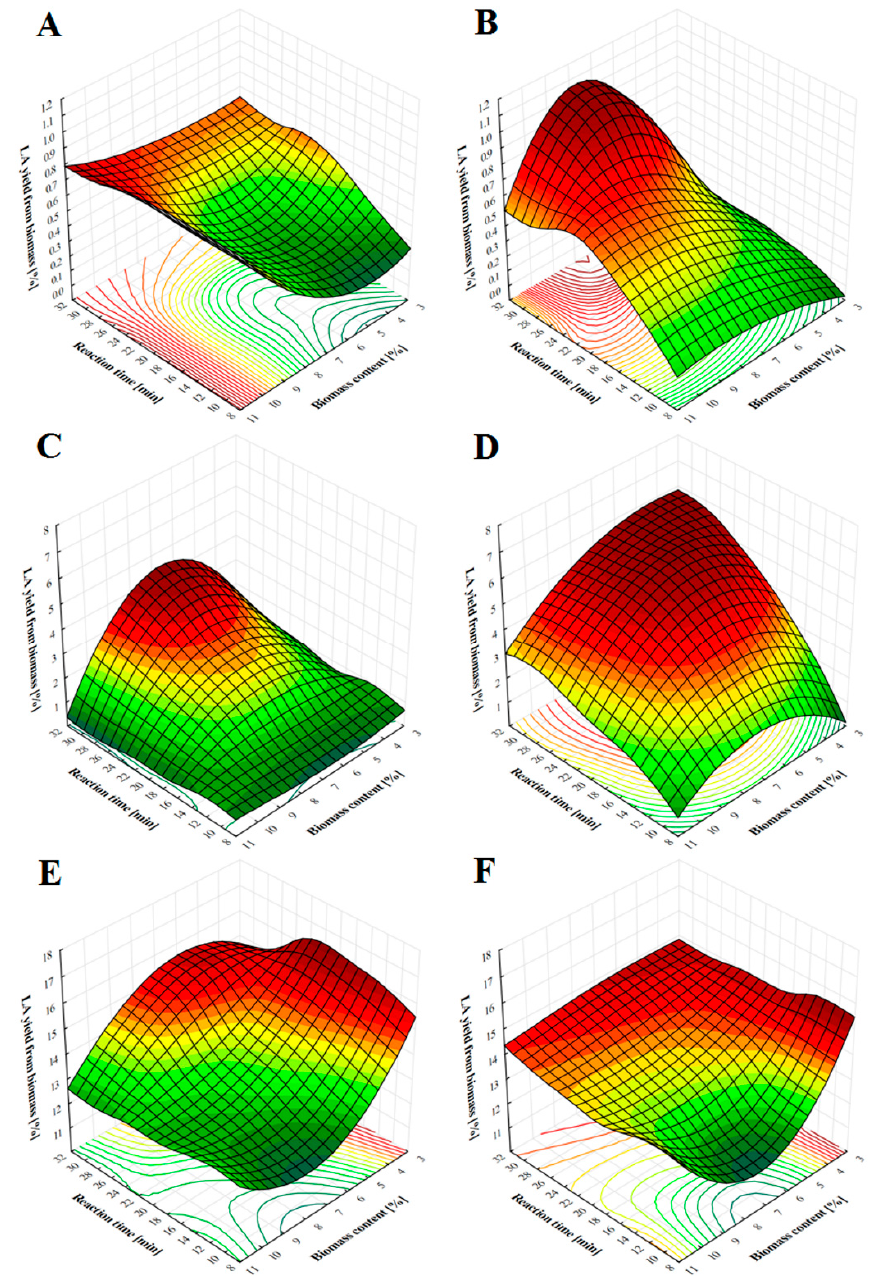
Figure 5. Response surface plot showing the effect of the interaction between biomass content of sweet cherry chips and reaction time of microwave-assisted conversion on the yield of production of levulinic acid using nitric acid at a concentration of 1% ( A ) and 2% ( B ), phosphoric acid at a concentration of 1% ( C ) and 2% ( D ) and sulfuric acid at a concentration of 1% ( E ) and 2% ( F